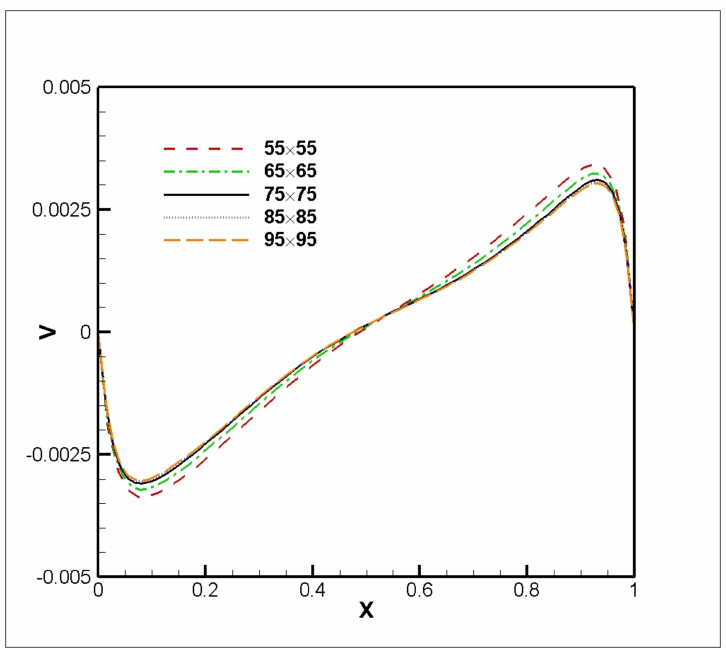
Figure 5. Profiles of vertical velocity V versus X -axis at Y = 0.5 for Gr = 100, Ri = 0.01, and = 0.05, φ = 0.0. φ Al 2 O 3 Cu